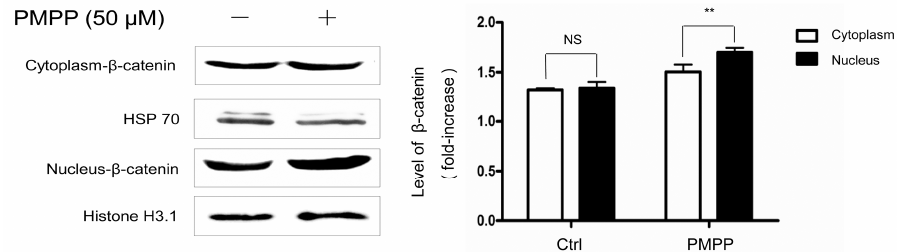
Figure 6. PMPP promotes β -catenin nuclear translocation. B16 cells were treated with PMPP of 50 µ M for 12 h, and the expression levels of proteins, including β -catenin in the cytoplasm and nucleus, were detected by using a Western blot. Equal protein loading amounts were confirmed by HSP 70 expression in the cytoplasm and Histone H3.1 expression in the nucleus. Data from the densitometric scanning of band intensities obtained from three separate experiments are presented as means ± SD. NS: No statistical difference, ** p < 0.01 compared with untreated cells.